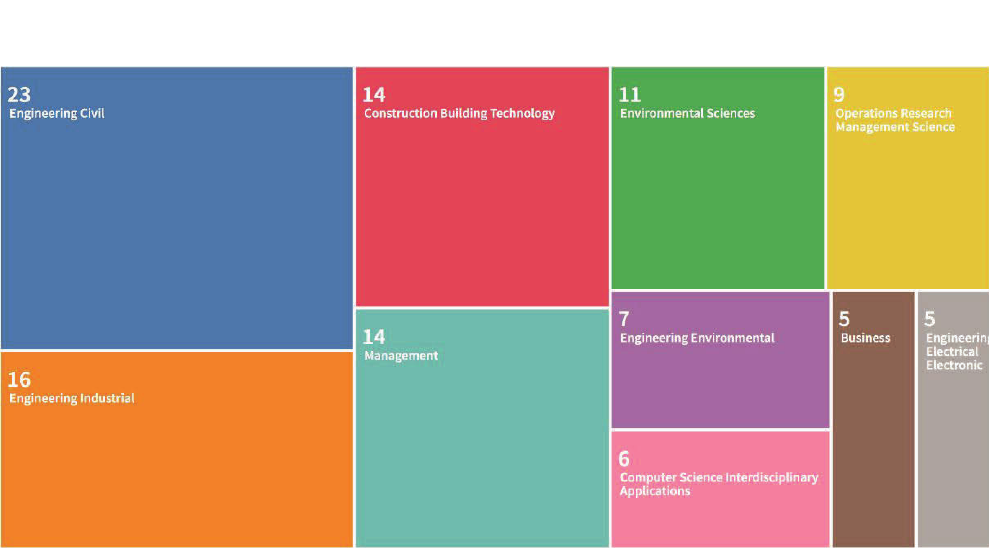
Fig. 4. Web of Science Core Collection database results by category. Source: Clarivate analytics